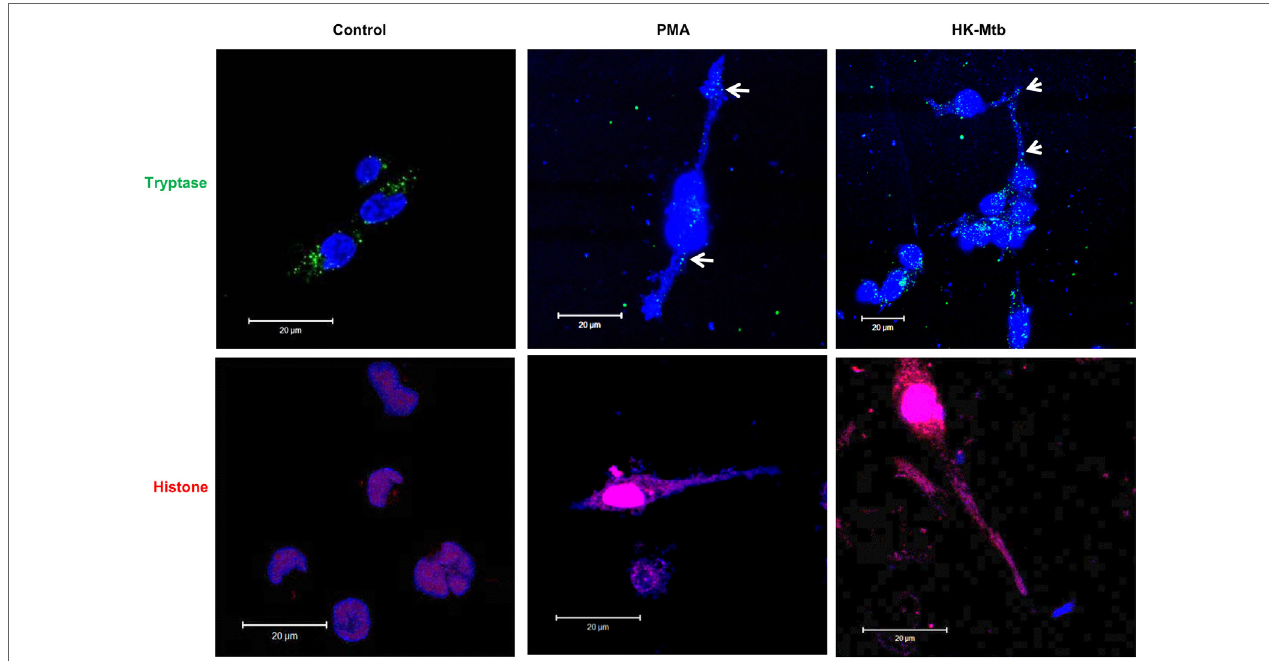
FigUre 2 | MCETs induced by heat-killed Mtb (HK-Mtb) contain both tryptase and histone. Representative micrographs of unstimulated HMC-1 mast cells (control) or stimulated for 2 h with PMA or HK-Mtb at a MOI of 10. Mast cell tryptase is shown in green, while histone is shown in red and DNA in blue. White arrows indicate DNA zones that showed co-localization with mast cell tryptase. Scale bar 20